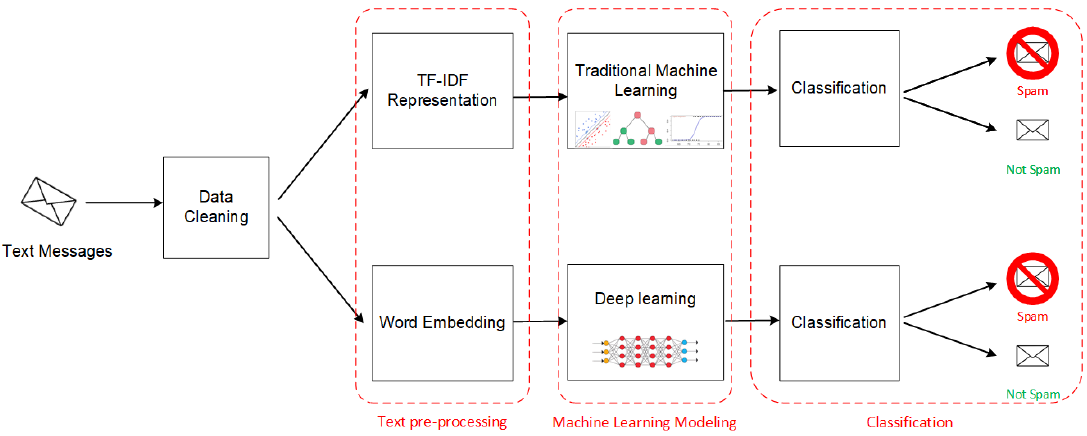
Figure 1. Architecture of the spam detection